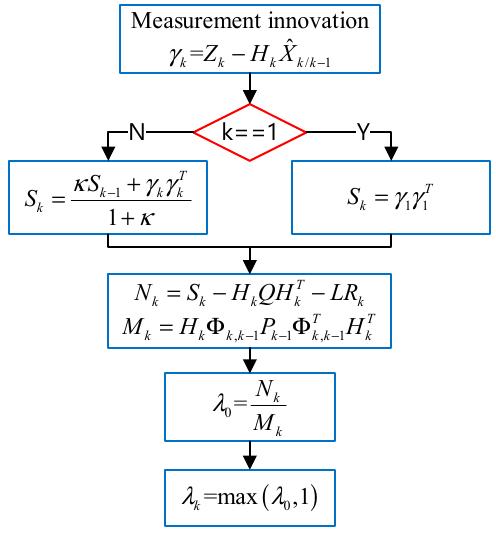
Figure 2. Time-varying fading factor calculation process.